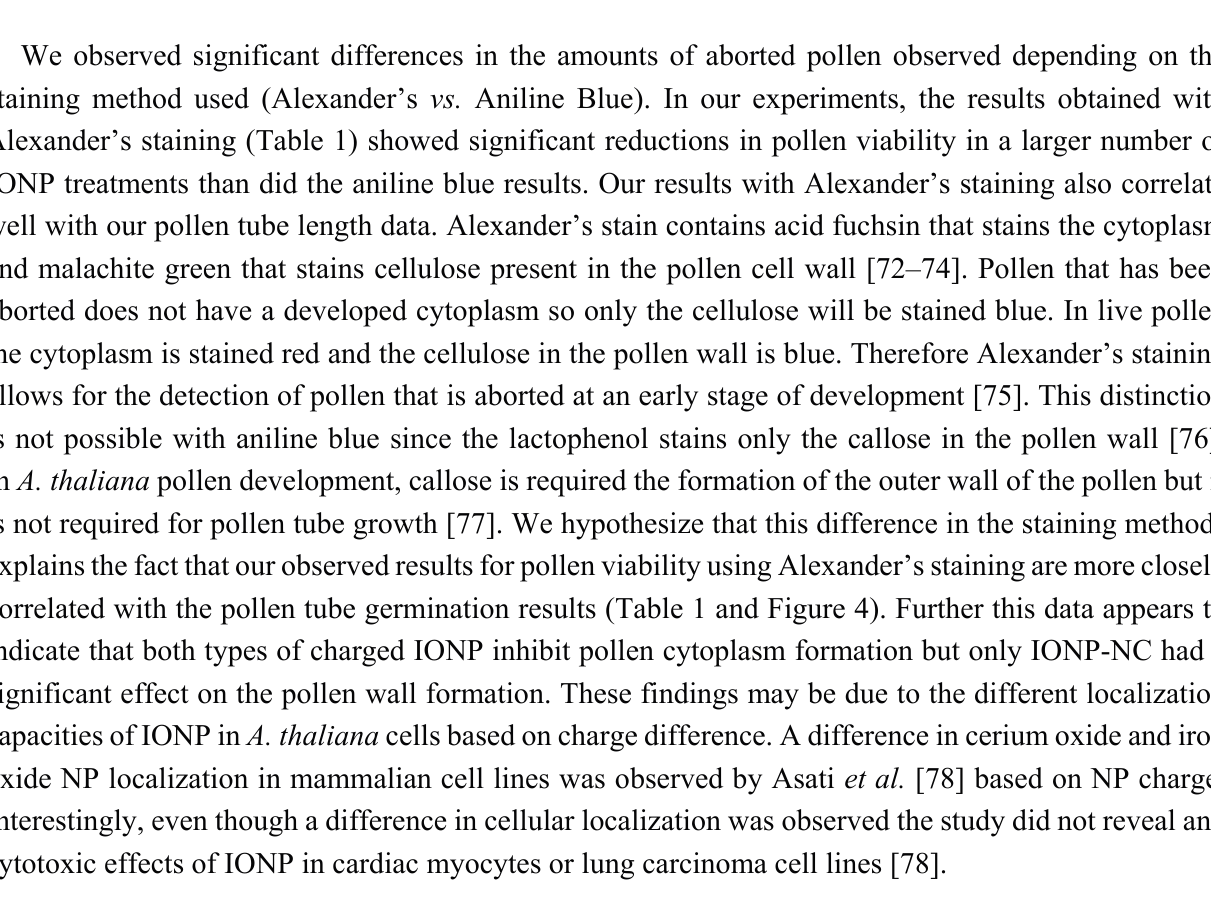
Figure 4. Effects of IONPs on Pollen tube growth in A. thaliana . Plants were treated with 30 mL of a solution containing IONP-PC or IONP-NC at a concentration of 3 mg/L either once (14 dap; gray bars); twice (14 & 21 dap; blue bars) or three times (14, 21 & 28 dap; red bars) and compared with dH 2 O only controls. Pollen was then collected from fresh flowers of treated plants and grown on pollen tube germination media for 18 h before pollen tube length was measured. Treatments with significant differences from the control are marked with an asterisk ( p < 0.05). For all experiments n =